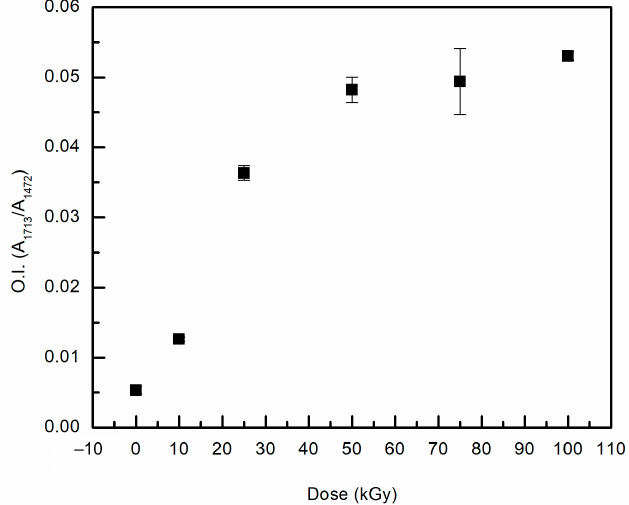
Figure 5. Oxidation index for all gamma irradiated UHMMPE fibers at different doses.